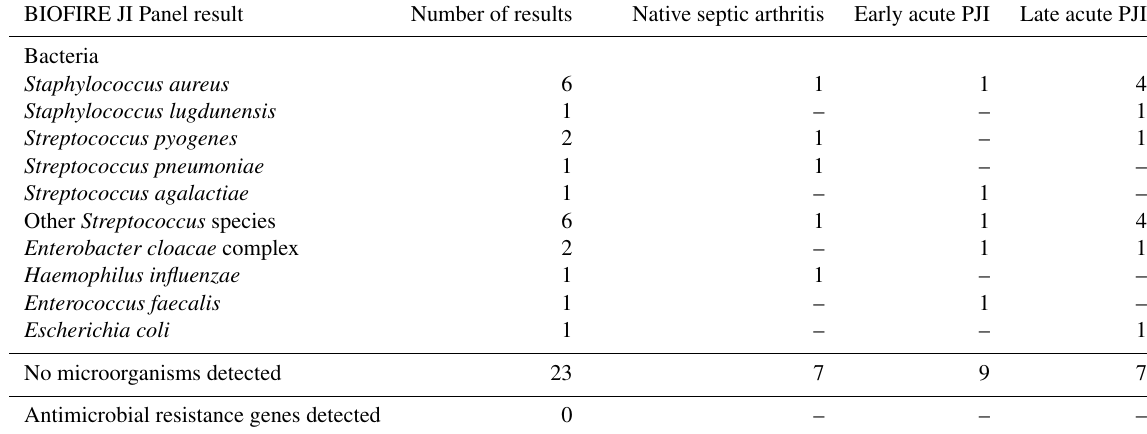
Table 2. Results of the BIOFIRE JI Panel from 45 synovial fluid samples obtained from patients with a clinical suspicion of native septic arthritis, early, or late acute PJIs.